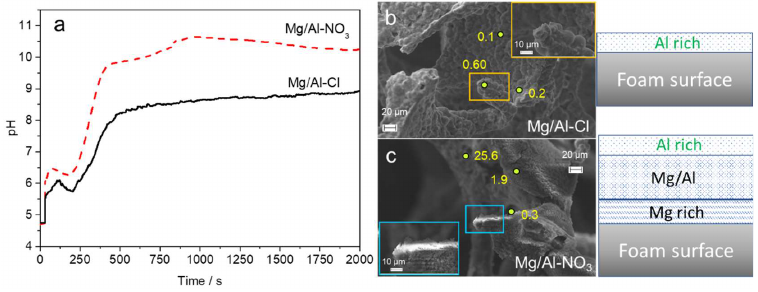
Figure 1. ( a ) Evolution of the pH near the foam surface dipped in 0.06 M Mg/Al-Cl and 0.06 M Mg/Al-NO 3 solutions during the current transient curve (−1.2 V vs. SCE for 2000 s); ( b , c ) SEM images of the respective coatings. The numbers in SEM images are the Mg/Al ratio values recorded for some regions of interest. Adapted from [53].